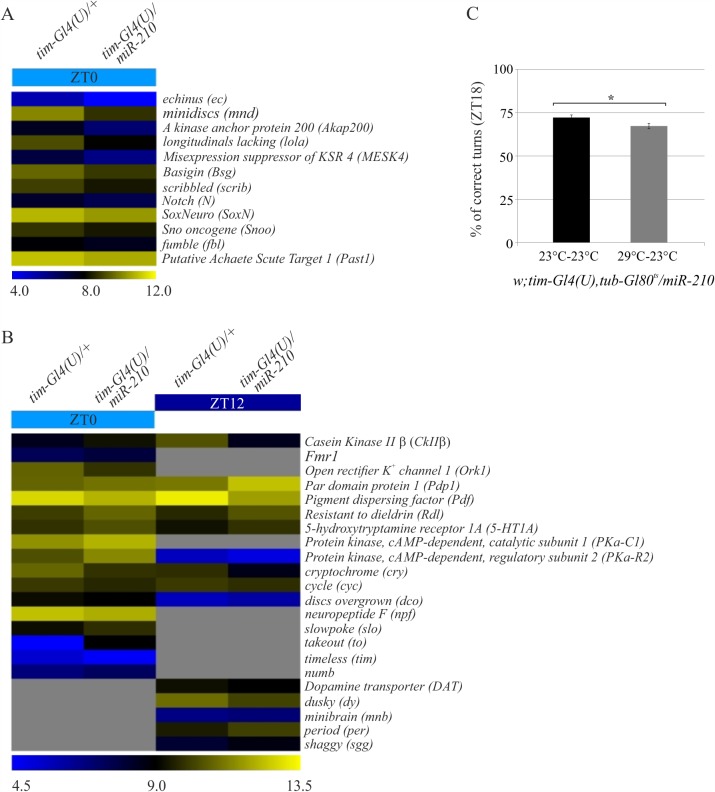
Altered gene pathways in miR-210 over-expressing flies.Heat maps representing a selection of deregulated transcripts, provided by the DAVID tool, in tim-Gl4(U)/UAS-miR-210 versus control samples (tim-Gl4(U)/+) involved in (A) phototransduction (12 transcripts). A color-coded scale for the normalized expression values is used: yellow and blue represent high and low expression levels in miR-210 over-expressing flies, compared to controls. The expression level of each transcript was calculated as Log2 (miR-210/CTRL). A complete list of differentially expressed genes identified by SAM two class algorithm is provided in the Supplementary Information (S3 and S9 Tables). (B) Heat map representing deregulated transcripts, provided by the DAVID tool, in tim-Gl4(U)/UAS-miR-210 versus control samples (tim-Gl4(U)/+) involved in circadian rhythms (22 transcripts), at ZT0 and ZT12. (C) Optomotor responses at ZT18 of tim-Gl4,tub-Gl80ts/UAS-miR-210 flies kept at 23°C (23°C-23°C) or 29°C (29°C-23°C) during development. A total of 100 flies per genotype were analysed. miR-210 over-expressing flies (grey) showed a significant decrease in the optomotor response compared to controls (black). (Mean ± SEM; t-test * p<0.05).